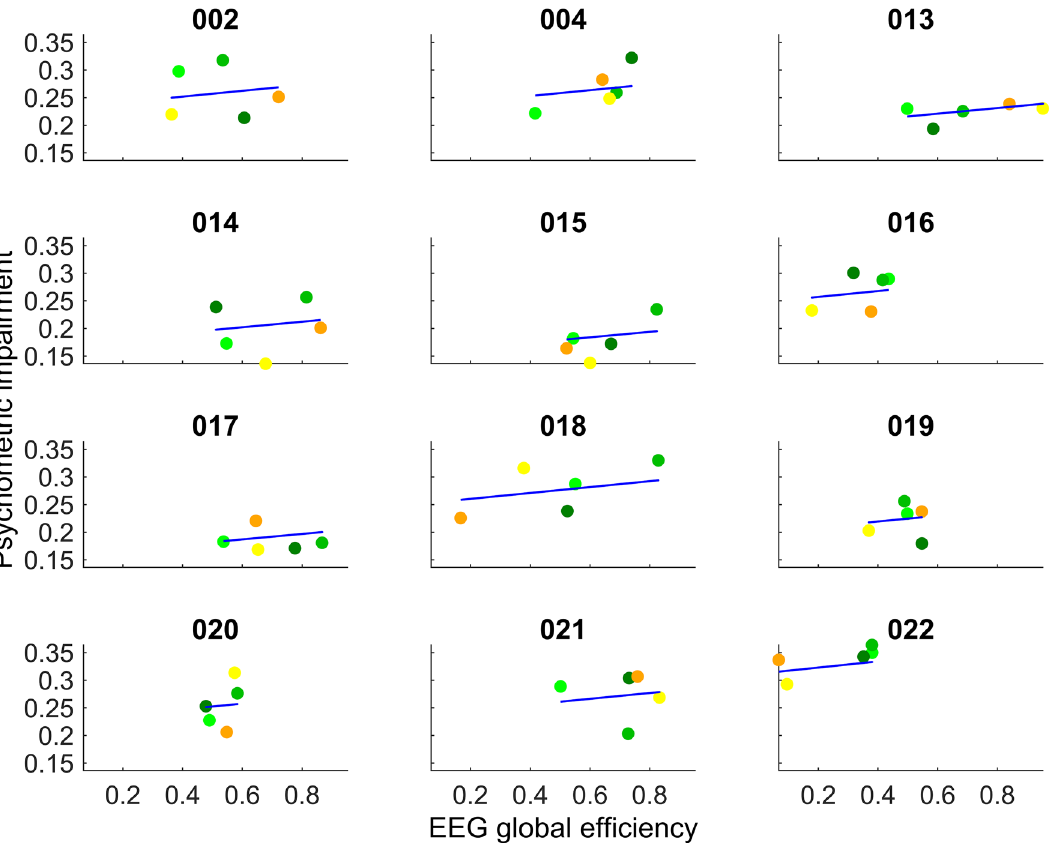
Figure 5. EEG mutual information based global efficiency metric versus psychometric impairment for each subject. Colored dots depict each exposure (light green = air baseline, middle green = 284 kPa air, dark green = 608 kPa air, yellow = heliox baseline and orange = 608 kPa heliox). Blue lines are the fitted model.